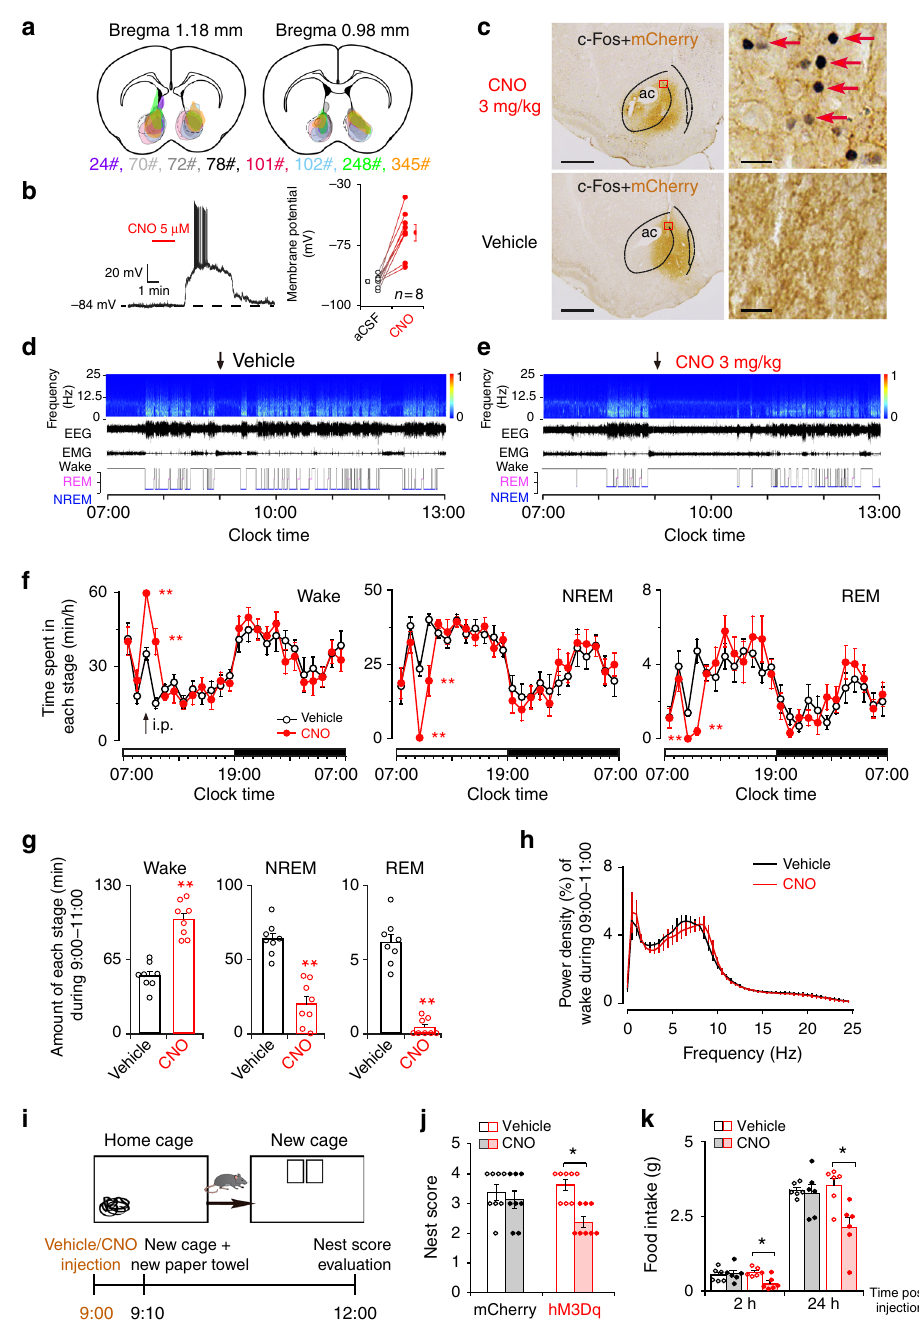
Fig. 2 Chemogenetic activation of NAc D 1 R neurons increases wake and suppresses nest-building behavior and food intake. a Drawings of superimposed AAV injection sites in the NAc of D 1 R-Cre mice ( n = 8, indicated with different colors). b Representative voltage traces recorded from an mCherry- expressing neuron during the application of CNO. CNO produced depolarization and fi ring in an hM3Dq-expressing neuron (left), and induced signi fi cant depolarization in hM3Dq-positive D 1 R neurons (right, n = 8 cells from 3 mice, paired t test; t 7 = 5.8, P = 7 × 10 − 4 ). aCSF arti fi cial cerebrospinal fl uid. c Representative images of CNO-induced c-Fos (black)/mCherry (brown) colocalization in the NAc. Scale bars: 500 μ m. Boxed regions in ( c ) are enlarged in the right panel. Scale bars: 10 μ m. d , e Examples of relative EEG power, EEG/EMG traces, and hypnograms over 6 h following vehicle ( d ) or CNO ( e ) injection at 09:00. f Time course changes in wakefulness, NREM sleep, and REM sleep after administration of vehicle or CNO to mice expressing hM3Dq in NAc D 1 R neurons ( n = 8, repeated-measures ANOVA; F 1,14 = 11.9 (wake), 11.6 (NREM), 12.4 (REM); P = 0.004 (wake), 0.004 (NREM), 0.003 (REM)). g Total time spent in each stage for 2 h after vehicle or CNO injection ( n = 8, paired t test). h EEG power density of wake during the 2 h after vehicle or CNO injection ( n = 8, paired t test; not statistically signi fi cant). i Diagram of experiment. j Nesting score was assessed in 4 groups ( n = 8 per group, Wilcoxon matched-pairs signed rank test: mCherry: Z = 0.6, P = 0.5; hM3Dq: Z = 2.3, P = 0.02). k Systemic application of CNO signi fi cantly reduced food consumption ( n = 6 per group, paired t test). Data represent mean ± s.e.m. * P < 0.05, ** P <